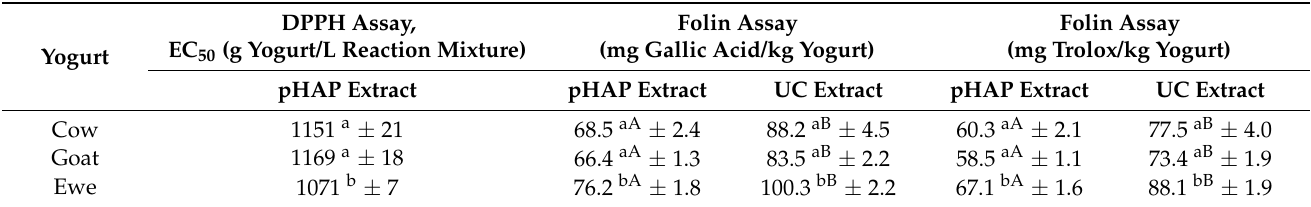
Table 3. Antioxidant activities of cow, goat and ewe yogurt preparations obtained by pH adjustment and precipitation (pHAP) or ultra-centrifugation (UC) procedure, as determined by DPPH and Folin assays 1 .